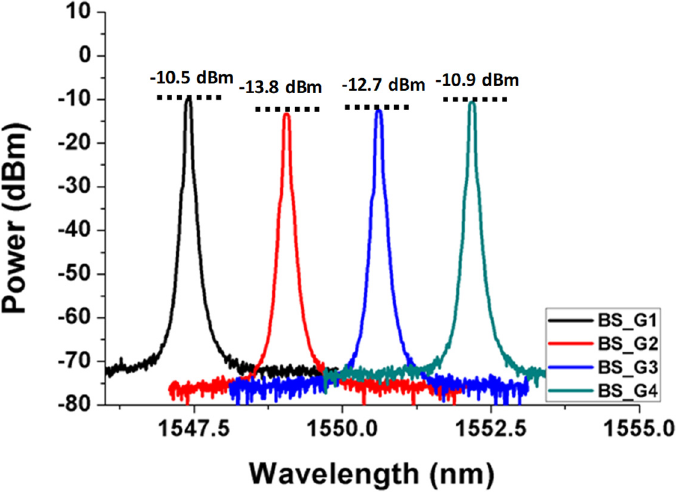
Figure 11. The optical spectra of uplink signals are measured at the CO end when a breakpoint occurs.